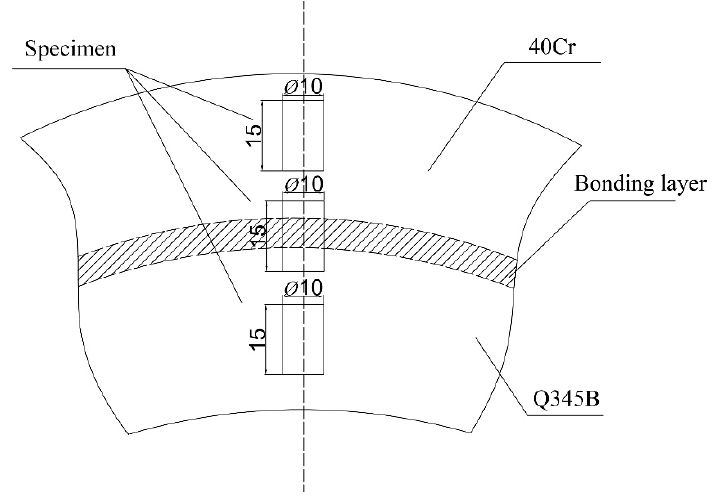
Figure 1. The sampling positions of 40Cr, Q345B, and bonding